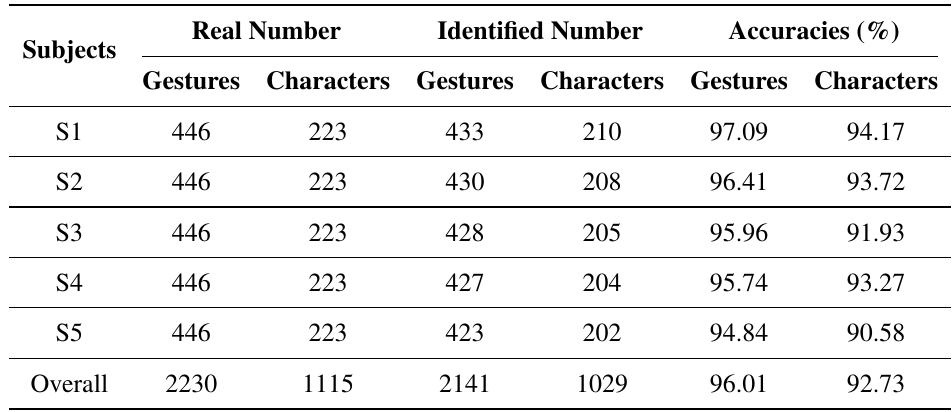
Table 1. The overall classification accuracies of continuous